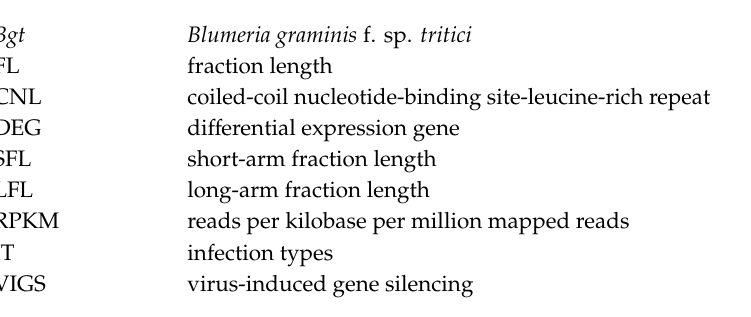
Table S1 List of unigenes of specifically expressed in 2011-400; Table S2 List of unigenes shared by all three Pm57 carrying lines; Table S3 List of genes and primers for qRT-PCR; Table S4 Results of qRT-PCR; Table S5 List of molecular markers of Ae. searsii chromosome 2S s #1 specificity and derived transcriptome unigenes used in this study; Table S6 List of CS- Ae. searsii 2S s #1 recombinants newly identified, their molecular markers presenting, and response to Bgt -infection; Table S7 Collineary analysis of Pm57 mapped genomic region with related